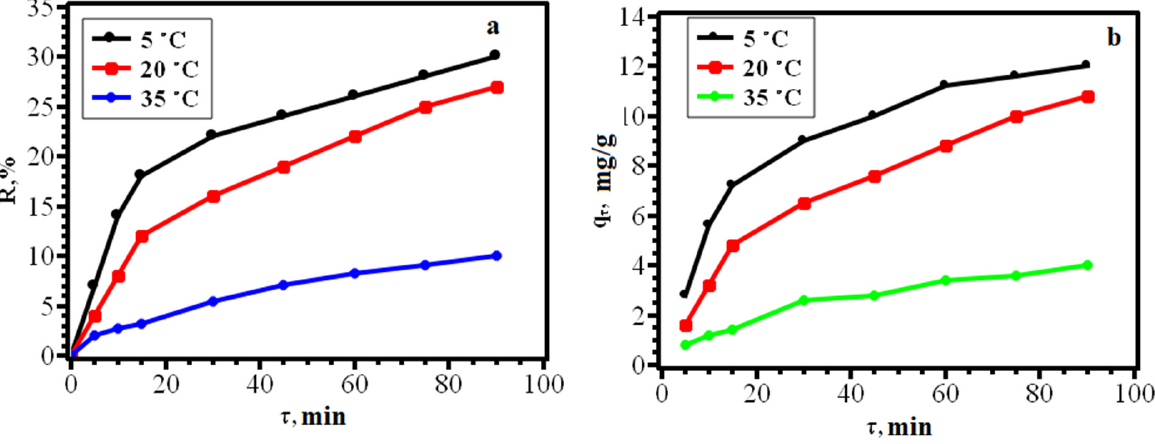
Figure 9. Degree of extraction ( a ) and kinetic curves ( b ) of solid-phase extraction versus contact time for IC dye.